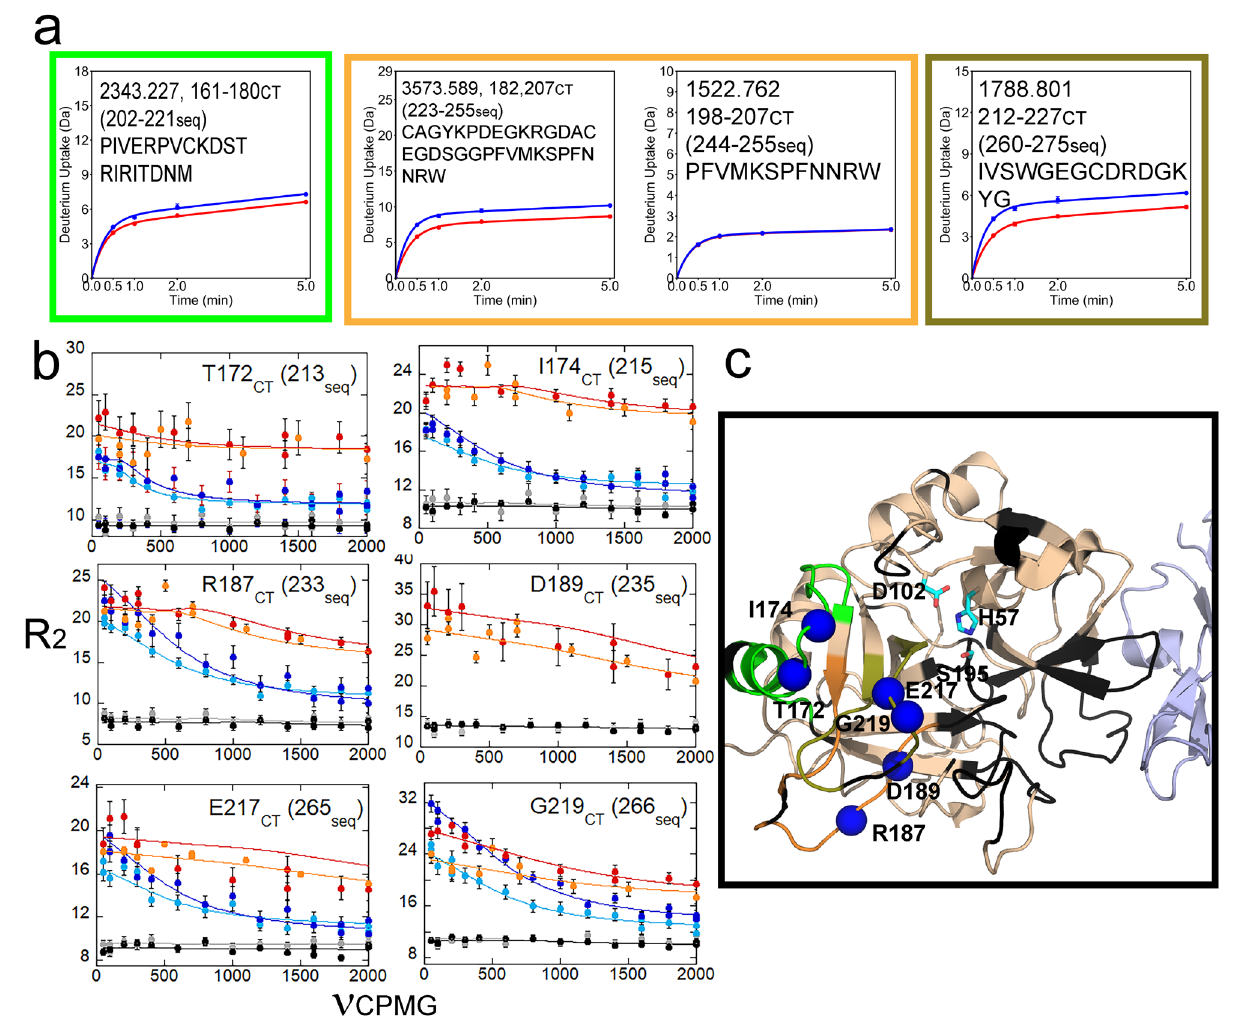
Figure 3. ( a ) Deuterium uptake plots for the peptides spanning residues 161-180 CT (202-221seq; MH + 2343.227), 182-207 CT (223-255seq; MH + 3575.589), 198-207 CT (244-255seq; MH + 1522.762), and 212- 227 CT (260-275seq; MH + 1788.801). ( b ) CPMG plots for resonances experiencing reduced μs-ms dynamics around the S1 pocket when TM456 is bound compared to apo-thrombin (symbols as in Fig. 1). ( c ) Structure of thrombin (wheat) bound to TM456 (light blue) [PDB ID: 1DX5]. The residues within the peptides identified in panel (A) are colored accordingly. Residues with missing HSQC resonances (black) and residues corresponding to resonances experiencing reduced μs-ms dynamics in thrombin-TM456 compared to apo-thrombin (blue spheres) are showed μs-ms timescale dynamics in apo thrombin, but this resonance became a doublet in the thrombin-TM456 HSQC spectrum (Fig. 4c). Finally, V213 CT (261seq) was also a doublet only in the thrombin-TM456 HSQC spectrum (Fig. 4c). Adjacent to Val 158 CT , Asn 159 CT was a doublet only in the thrombin-TM456 complex, and it was experiencing different chemical environments on the μs-ms timescale in apo-thrombin but not in the thrombin-TM456 complex (Fig. 4b,c). The core of the C-terminal β-barrel is flanked by Phe 199 CT (245seq) which also was a doublet in the thrombin-TM456 HSQC spectrum and showed μs-ms timescale dynamics in all three thrombin states (Fig. 4b,c). Tyr 228 CT (276seq) could be assigned to both a doublet resonance and a singlet resonance with notably different chemical shifts (Supplementary Fig. 4). Thus, the addition of TM456 causes decreased H/D exchange in the loops around the thrombin S1 pocket, reduces μs-ms timescale dynamics, and also induces dynamics that are slow on the NMR timescale in the residues that make up the hydrophobic core of the C-terminal β-barrel.